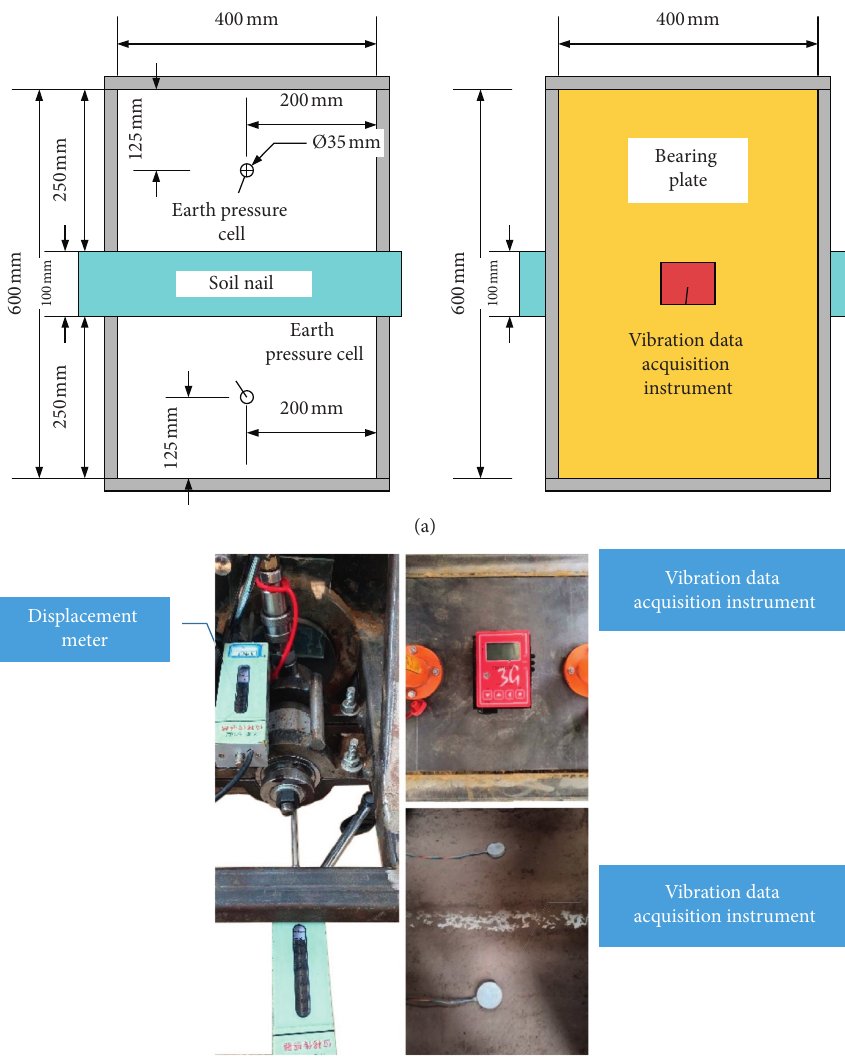
Figure 7: Layout of data measuring instruments. (a) Schematic diagram. (b) Test